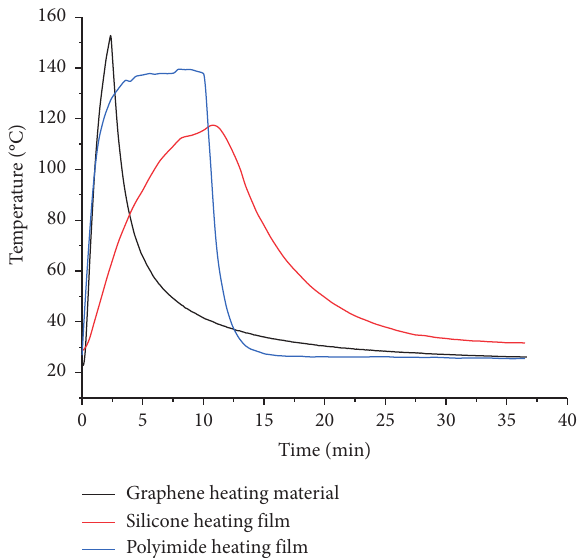
Figure 4: Heating characteristics of the three heating materials.